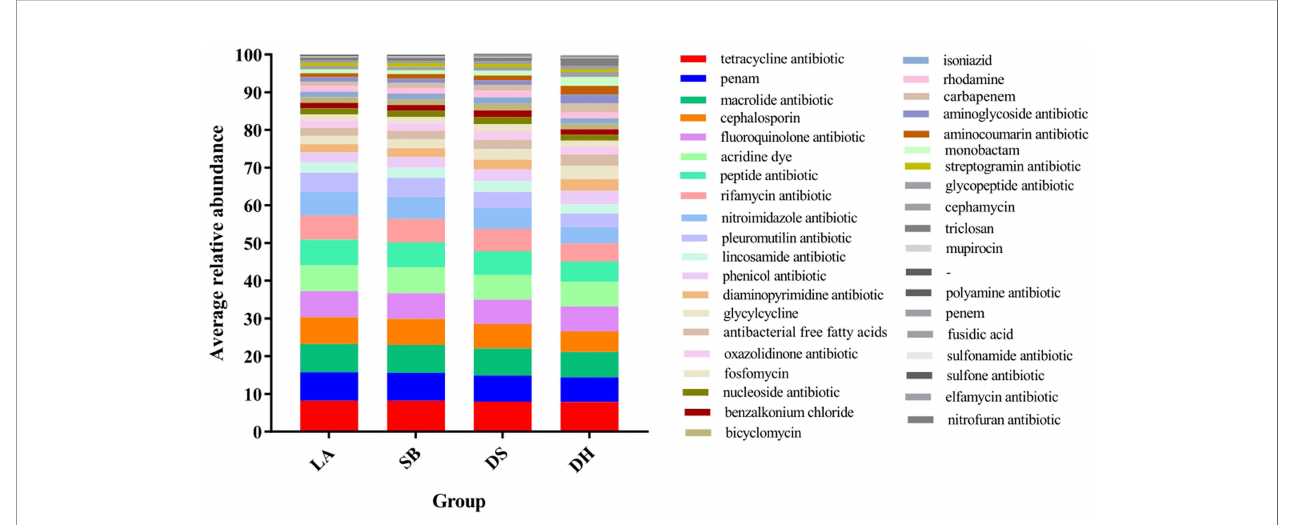
FIGURE 6 | Stack column of average relative abundance of antibiotic resistance genes in different categories among pig breeds.